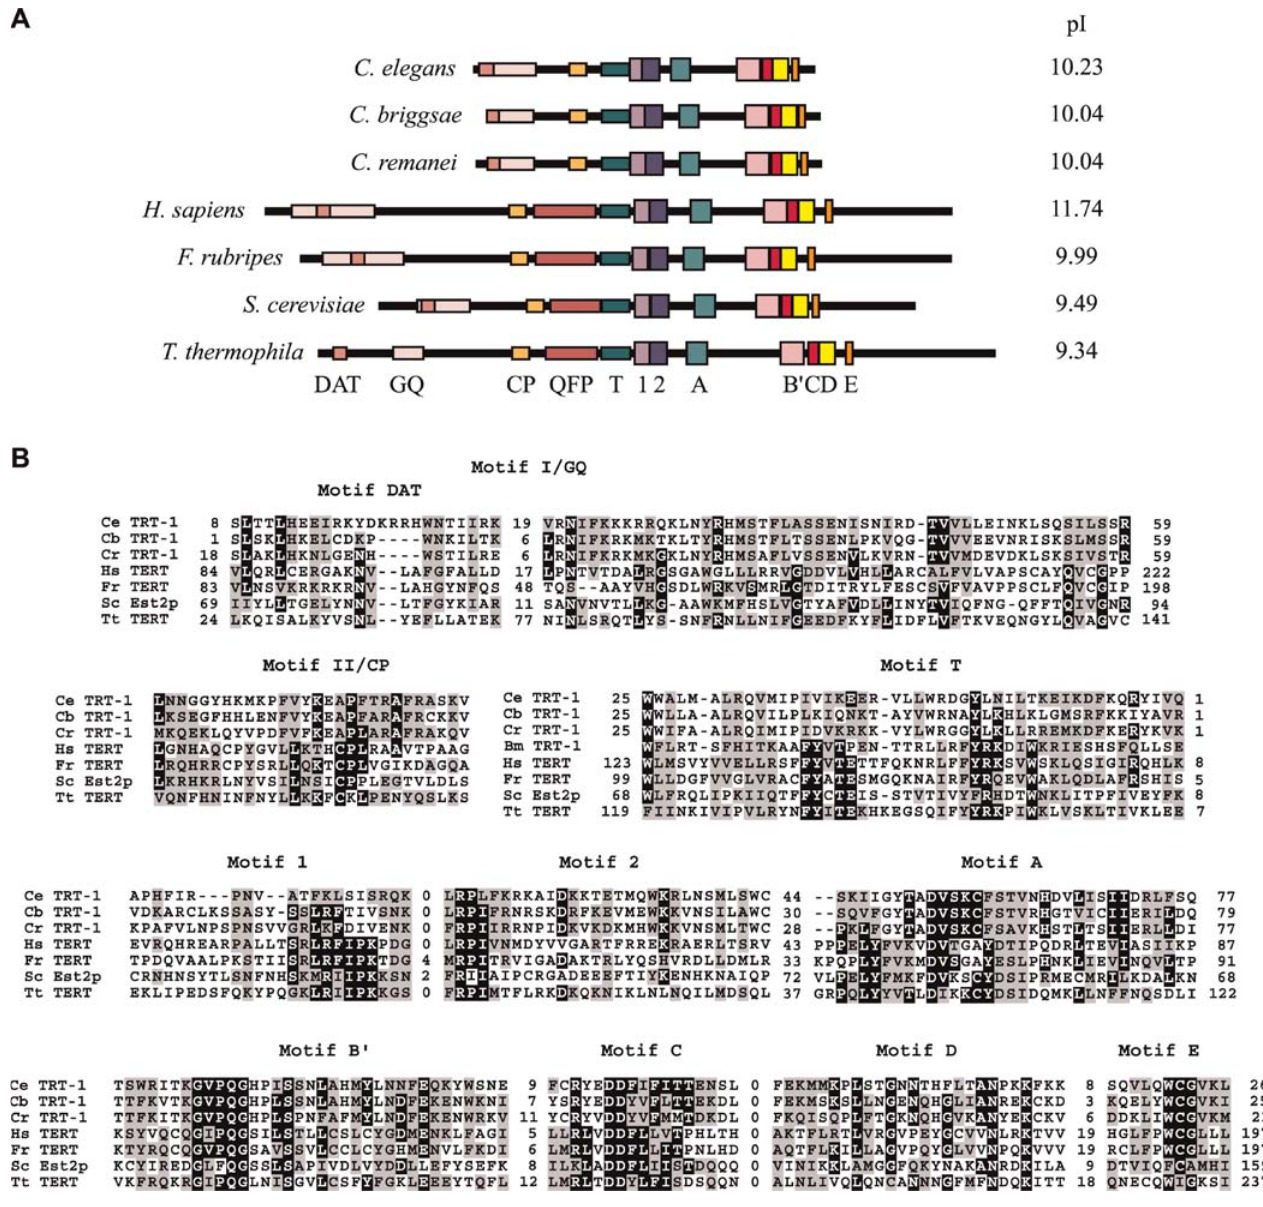
Figure 3. Structure and Sequence Motifs of Caenorhabditis TERT Proteins (A) Structure of TERT proteins from distantly related species, with isoelectric point (pI) indicated. (B) TERT sequence motifs include seven canonical reverse transcriptase motifs (1, 2, A, B 9 , C, D, and E) and several TERT-specific N-terminal motifs (I/DAT/ GQ, II/CP, and T) [18–20] for TERT proteins from three Caenorhabditis species; C. elegans (Ce), C. briggsae (Cb), and C. remanei (Cr); from the vertebrates H. sapiens (Hs) and Fugu rubripes (Fr); and from Saccharomyces cerevisiae (Sc) and Tetrahymena thermophila (Tt). An additional motif T is included for the nematode Brugia malayi (Bm), as this sequence was critical for precisely defining the Caenorhabditis motif T. Only portions of motif I/GQ and motif DAT with homology to the Caenorhabditis TERT proteins are shown. Motif DAT is a specialized protein domain within motif I/GQ that is known to be required for telomerase activity in vivo [42]. A clearly defined III/QFP N-terminal motif was not identified for the Caenorhabditis TERTs. The Brugia malayi T motif is based on a short expressed sequence tag, and further N-terminal motifs could not be discerned from the current genome sequence